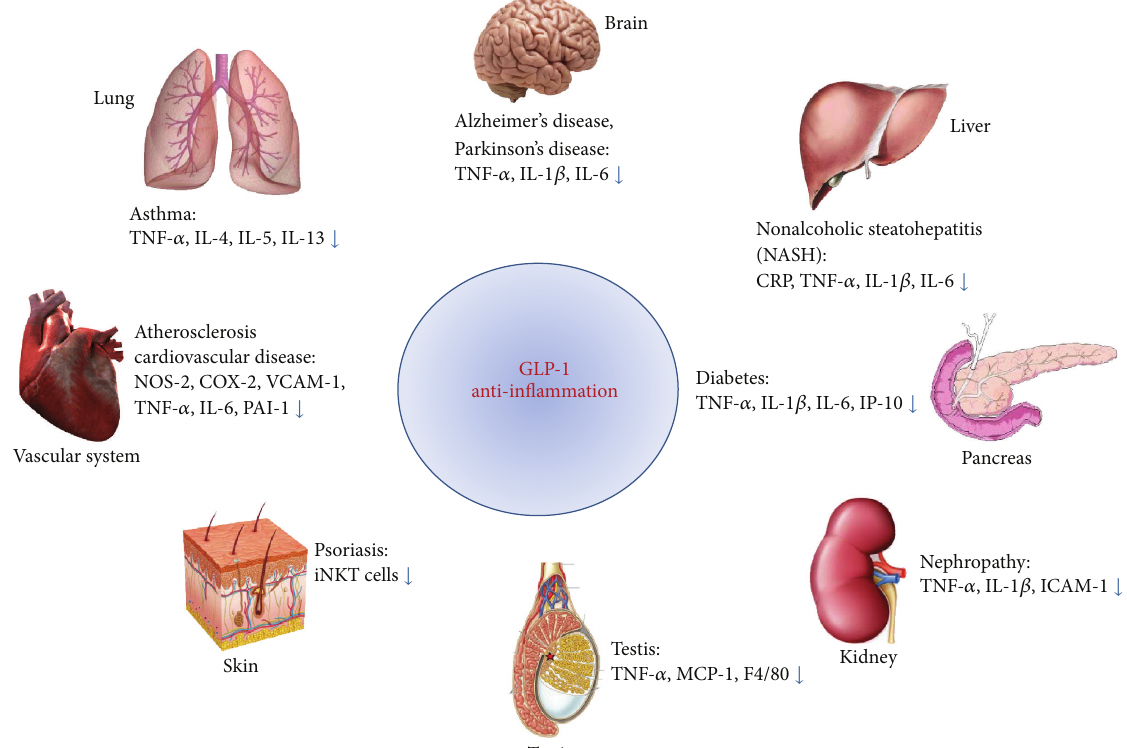
Figure 2: GLP-1-based therapies, including GLP-1, GLP-1R agonists and DPP-4 inhibitors, have anti-inflammatory functions in several